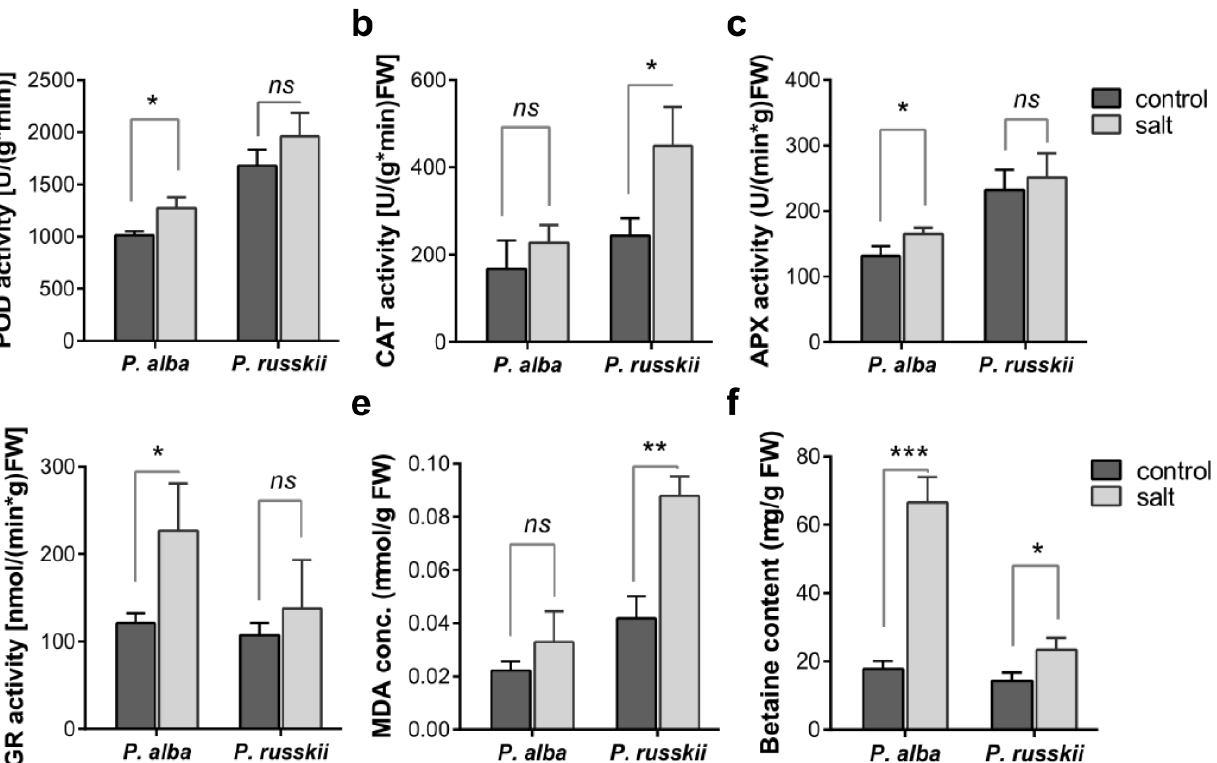
Figure 2. Antioxidant enzyme activities, MDA concentration, and glycine-betaine content in leaves of the two Populus species under salinity stress. ( a ) POD activity, ( b ) CAT activity, ( c ) APX activity, ( d ) glutathione reductase (GR) activity, ( e ) MDA concentration and ( f ) glycine-betaine content in P. alba and P. russkii leaves under NaCl treatment for 12 days. Bar indicates the mean ± SD (n = 3), *, p < 0.05, **, p < 0.01, ***, p < 0.001, ns, p > 0.05, two-tailed t -test.